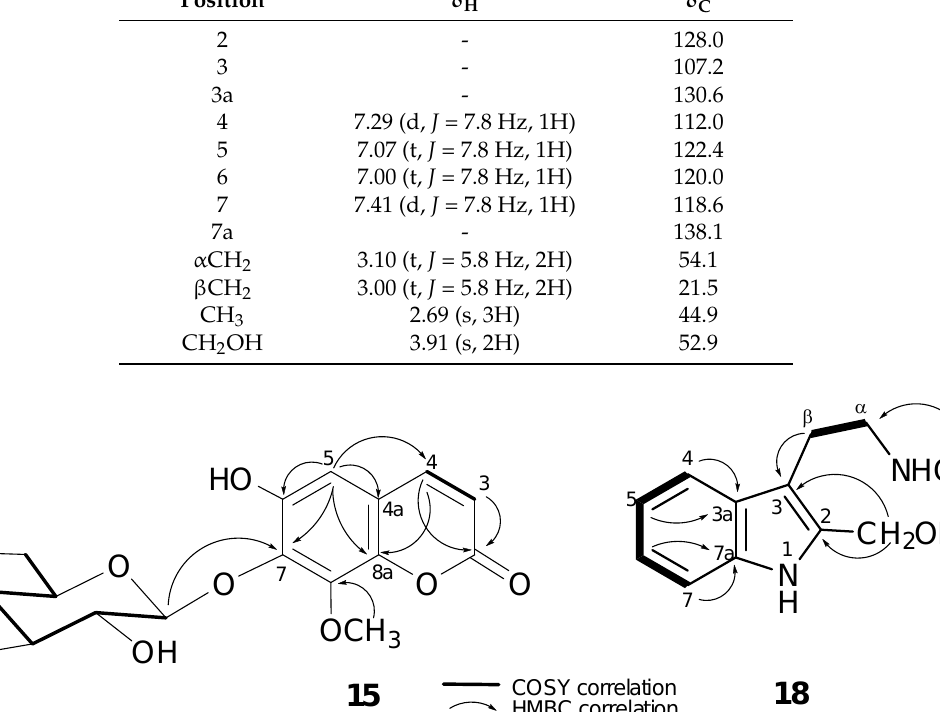
Figure 2. Selected heteronuclear multiple bond correlation (HMBC) and correlation spectroscopy (COSY) correlations of compounds 15 and 18 .